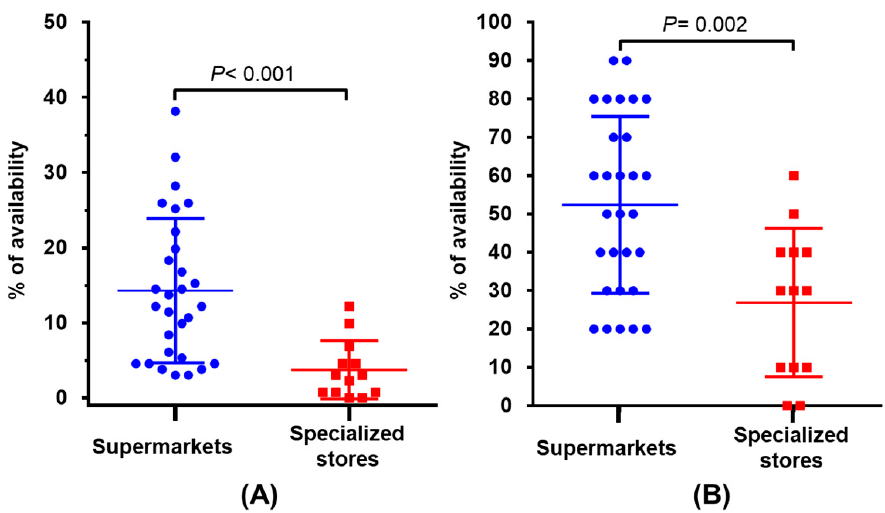
Figure 1. Availability of cereal-based products labeled as sugar-free (SF), sugar-reduced (SR), or low glycemic index (low GI) in supermarkets and specialized stores. ( A ) Availability ( Ar p ) based on the total number of products ( n = 131); ( B ) Availability ( AR c ) considering the total of categories (10).